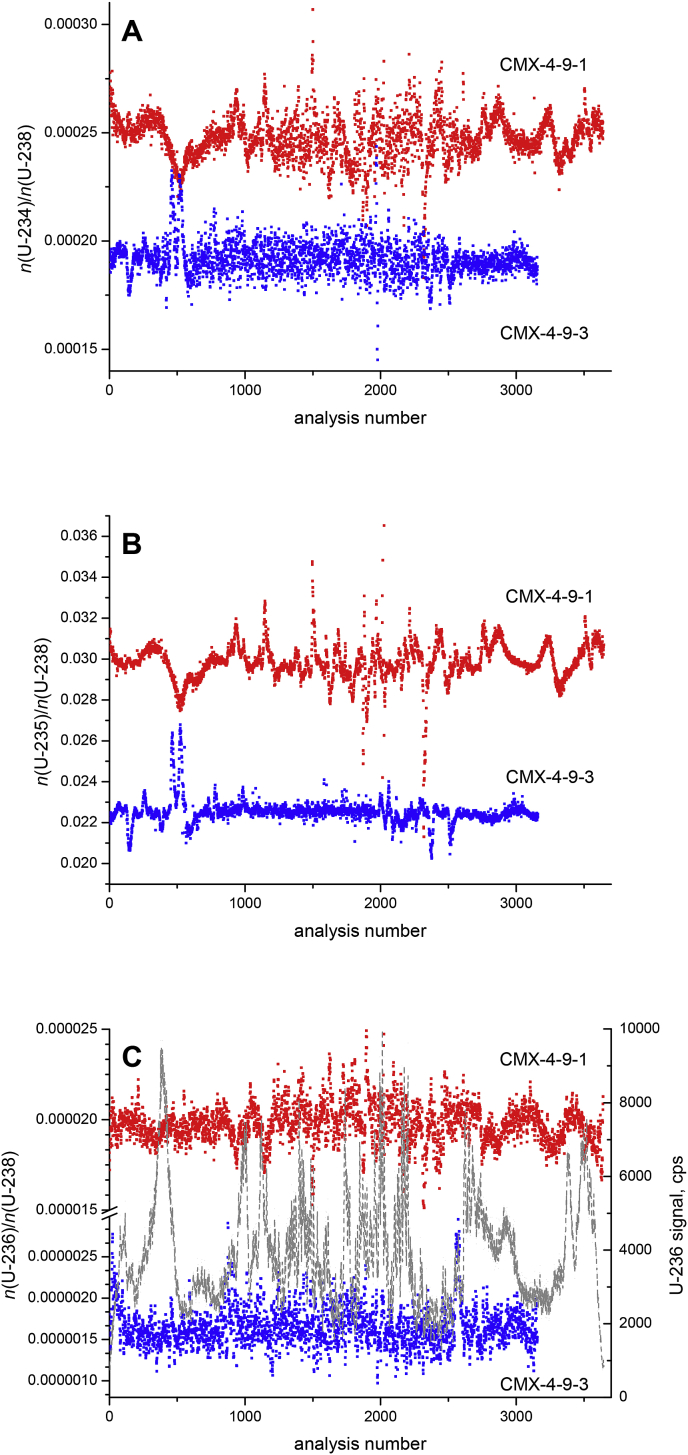
Line scan analysis of two low-enriched UO2 pellets revealing the spatial inhomogeneity with respect to their U isotopic composition. Samples CMX-4-9-1 and CMX-4-9-3 comprise 3618 and 3124 individual data points, respectively. A 5-point moving average was plotted for the minor U isotopes (panel A + C), to reduce the scatter of the individual data points. The dashed grey line in panel C represents the ion counter signal of 236U in counts per second (cps) during line scan analysis of sample CMX-4-9-1.